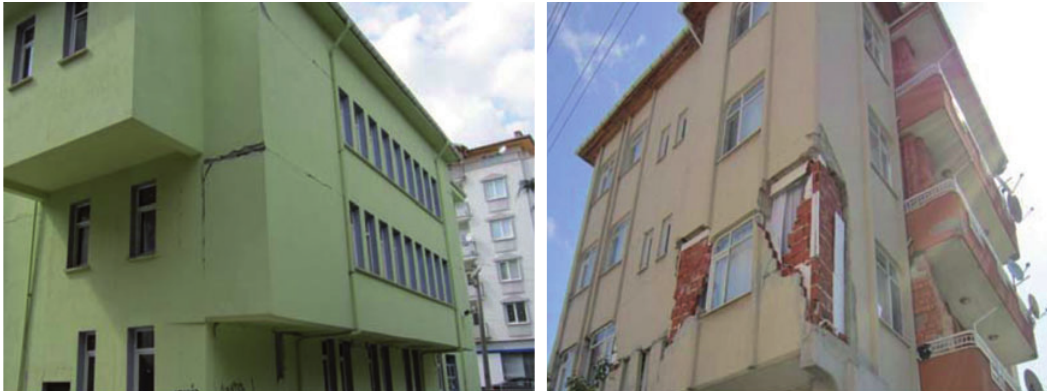
Figure 1 Damage to buildings after Kutahya earthquake [6]